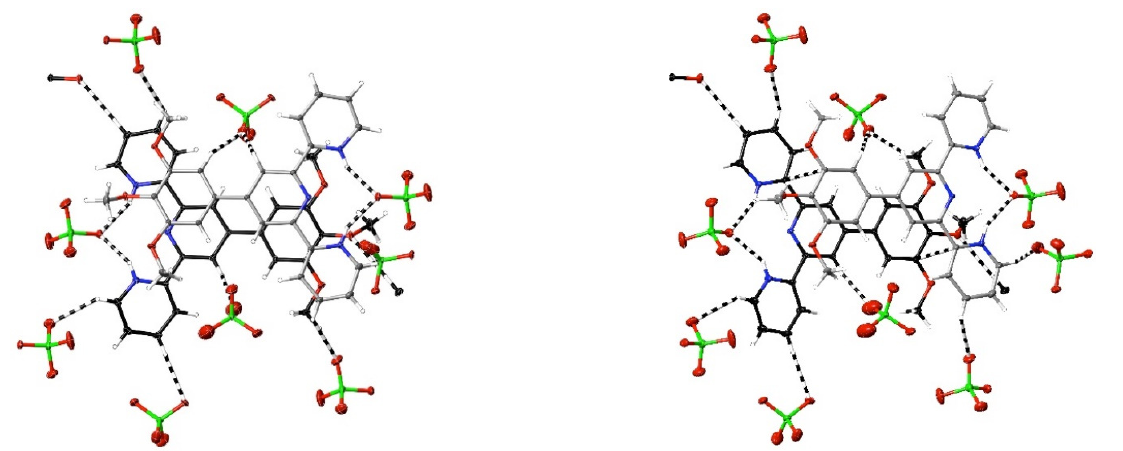
Figure 3. Views perpendicular ( left ) and at 30° ( right ) to the mean plane of one of the stacked pairs of inequivalent cations found in the structure of [H 2 tmptpy ](ClO 4 ) 2 · 0.5THF, 30 , showing (dashed lines) the interactions exceeding dispersion of the cations. Carbon atoms of one cation are shown in black; of the other, in grey. C ... C interactions are visible in the 30° view.